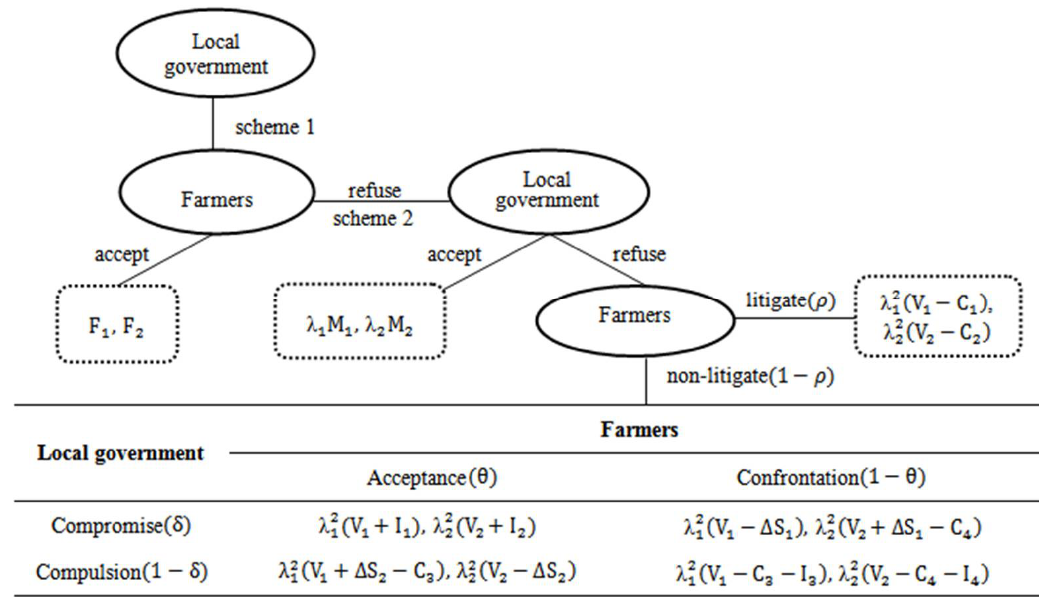
Figure 2. Two-stage van Damme’s game matrix with two players.